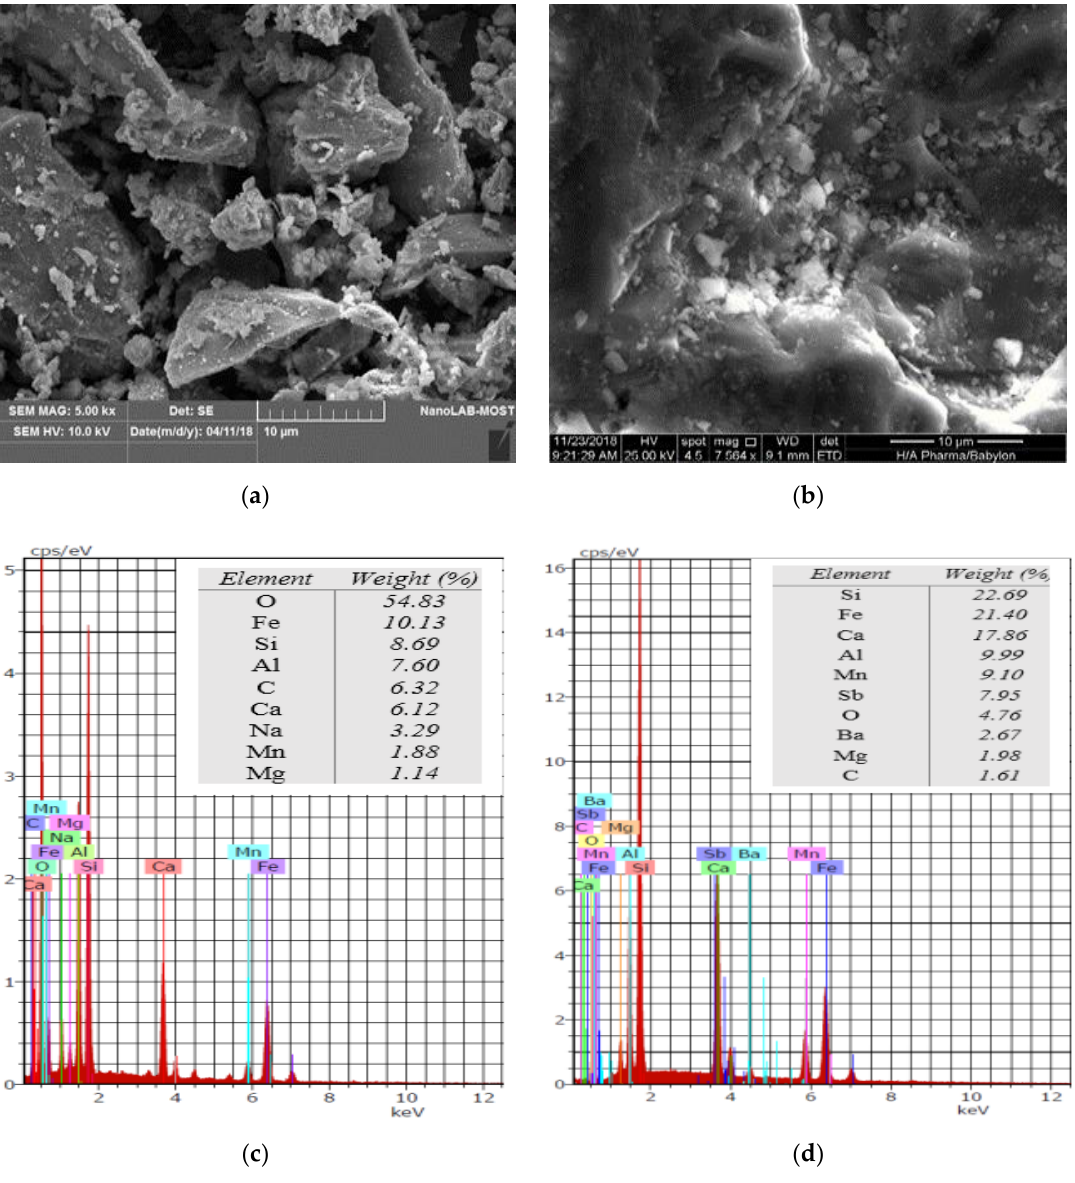
Figure 6. Scanning electron microscopy / energy-dispersive spectroscopy (SEM / EDS) for iron slag ( a ), ( c ) before and ( b ), ( d ) after adsorption of benzaldehyde from aqueous solutions. Table 5. The values of final pH and residual concentration of calcium after the sorption of benzaldehyde onto iron slag in comparison with the control test.